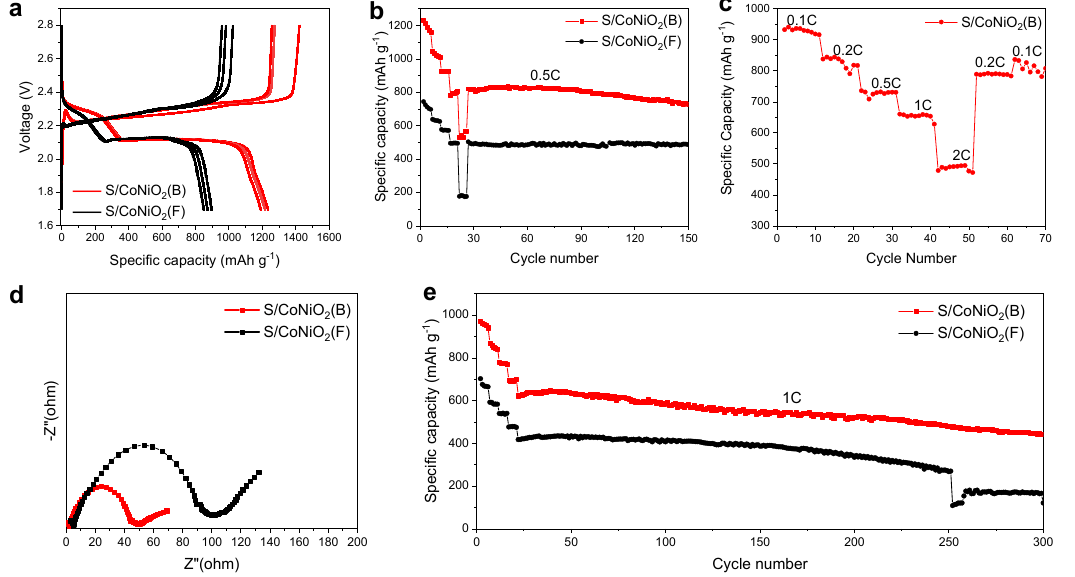
Figure 7. The electrochemical measurement of S/CoNiO 2 (B) and S/CoNiO 2 (F); ( a ) The voltage plateau curve of the S/CoNiO 2 (B) electrode at 0.05 C in initial three cycles. ( b ) Cycle performances of the S/CoNiO 2 (B) and S/CoNiO 2 (F) electrode at 0.5 C. ( c ) Rate performances of the S/CoNiO 2 (B) electrode. ( d ) EIS curves and ( e ) cycle performances at 1 C for the S/CoNiO 2 (B) and S/CoNiO 2 (F) electrode.